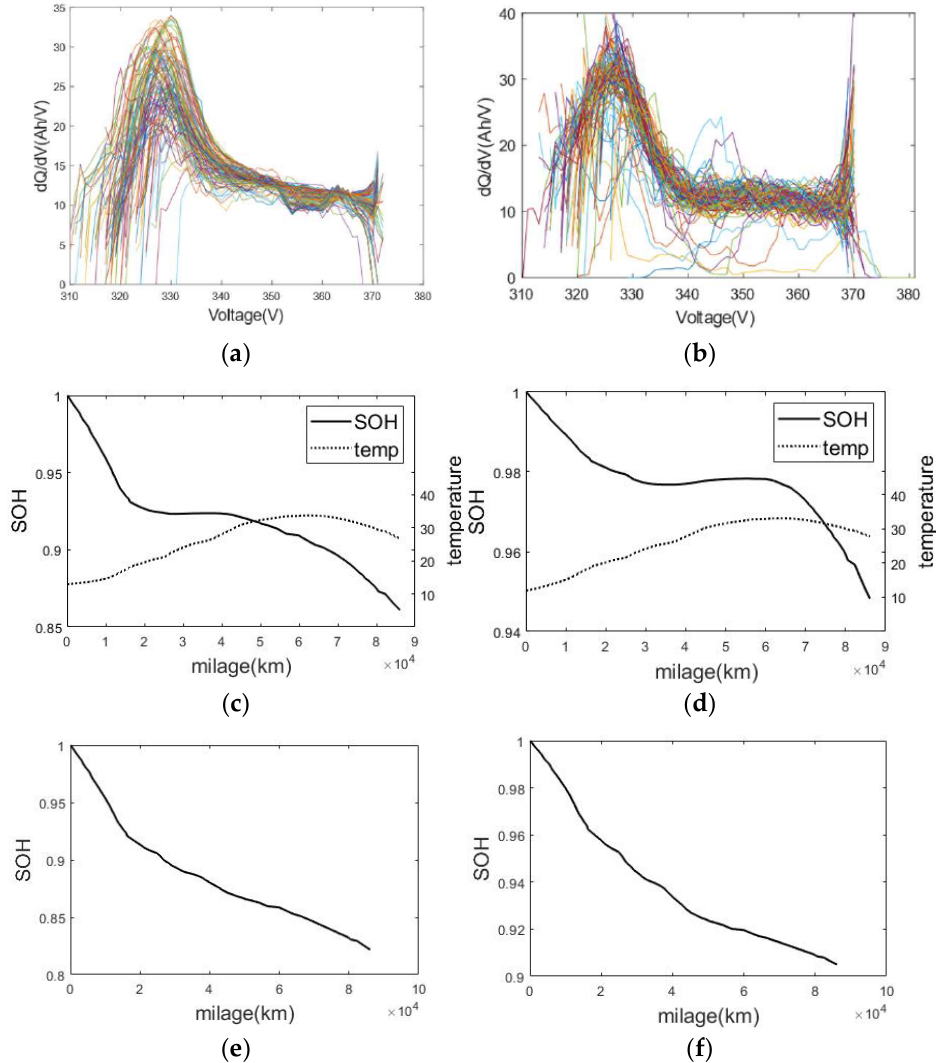
Figure 6. Battery pack SOH calibration results, ( a ) general charging trend, ( b ) general discharging trend, ( c ) before temperature correction with charging data, ( d ) before temperature correction with discharging data; ( e ) after temperature correction with charging data; ( f ) after temperature correction with discharging data.